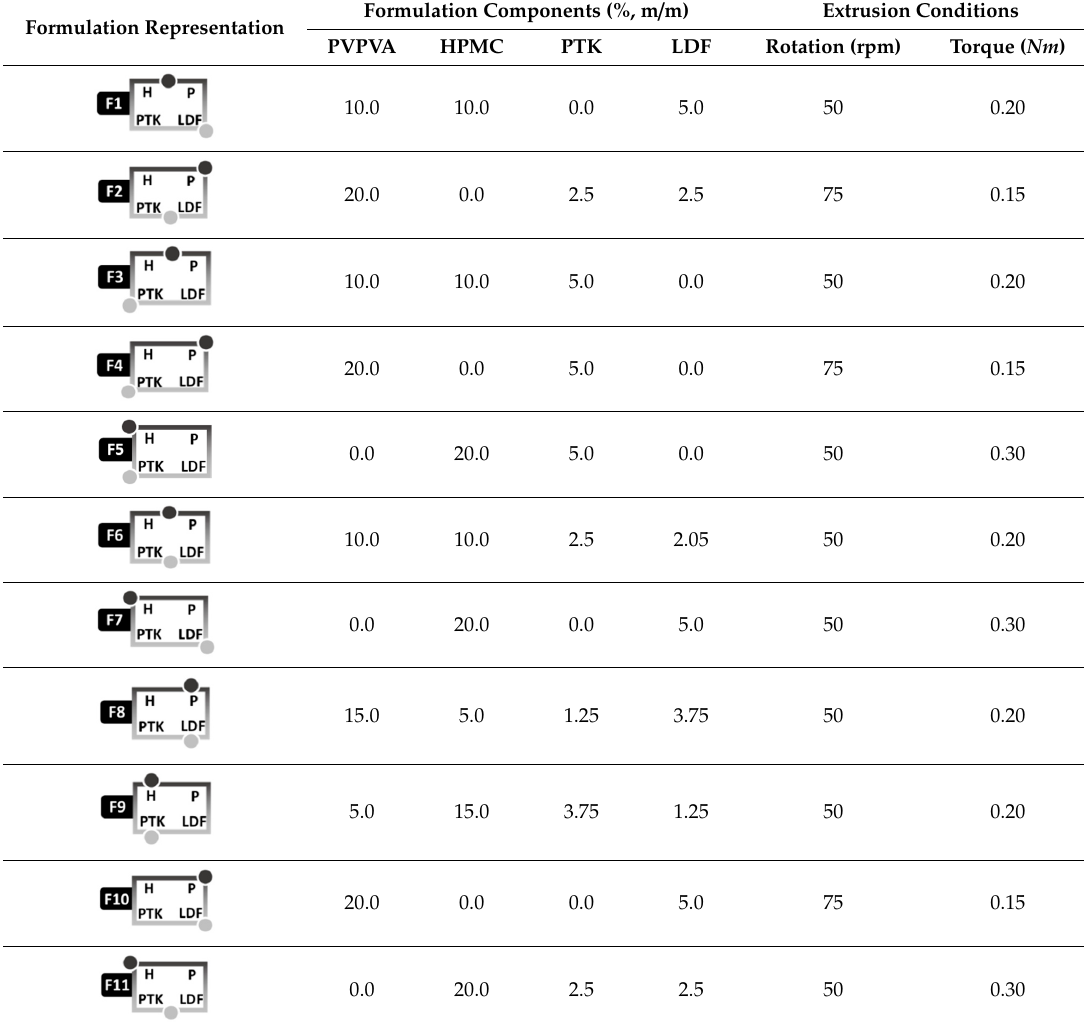
Table 1. Summary of the formulation composition according to the combined mixture design and their extrusion conditions. In formulations representation, H refers to HPMC and P to PVPVA.